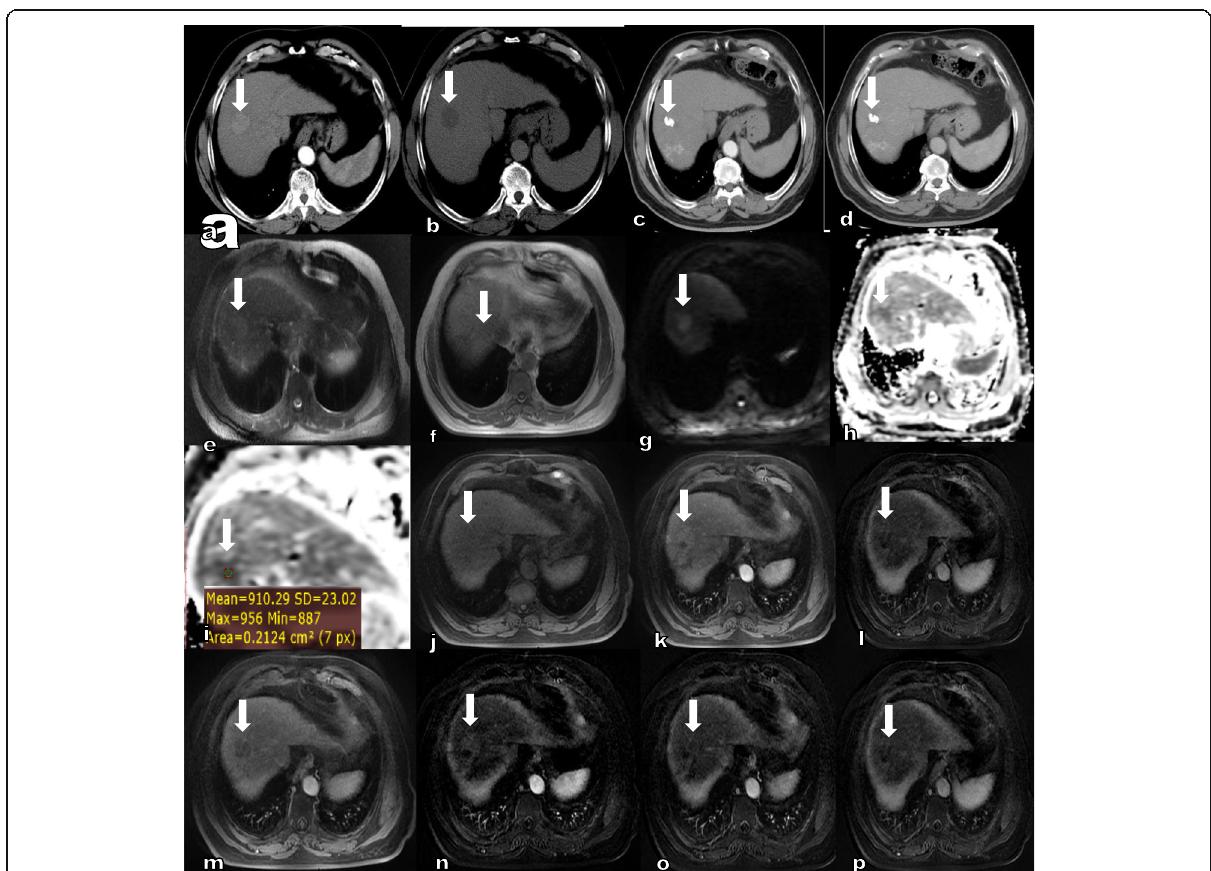
Fig. 1 A 66-year-old male patient having HCC underwent TACE ablation for one focal lesion involving right hepatic lobe segment VIII. a Pre-TACE CT-scan in the arterial phase showing intense enhancement. b Wash-out in delayed phase. c Follow-up with CT-scan showing no definite enhancement in the arterial phase. d No definite wash-out in delayed phase. e Yet the patient had high AFP level, so DCE MRI was done showing bright signals in T2. f Relative hypo-intense signals in T1 WIs. g Restricted diffusion in DWI at 800 b value. h Corresponding dark signals in ADC mapping series. i ADC value = 0.91 × 10 − 3 s/mm 2 . j Iso-intense signals in pre-contrast phase of LAVA. k Arterial enhancement in late arterial phase. l Wash out of the contrast in the porto-venous. m Delayed phase. n Being confirmed in subtraction images throughout arterial, o porto-venous, and p delayed phases. Final diagnosis: LR-TR viable 2.9 mm, (pretreatment, LR-5, 28